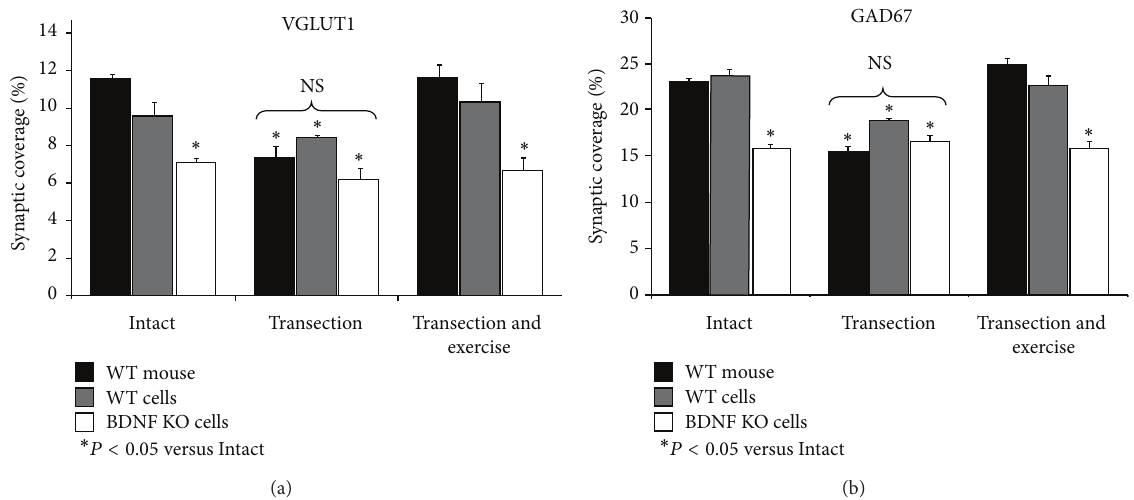
Figure 3: The mean (+SEM) percent of motoneuron somata and proximal dendrites that are contacted by structures immunoreactive for VGLUT1 (a) and GAD67 (b) in WT mice and for WT and KO cells in tamoxifen-treated SLICK::BDNF f / f mice are shown. Separate groups of three bars are shown in each panel for data from intact mice (left), unexercised mice two weeks after sciatic nerve transection (center), and two weeks after nerve transection and five days per week exercise (right) ( 𝑛 = 5 , 4, and 3 mice, resp.). The left group of results shows that synaptic coverage is significantly reduced in BDNF KO cells compared to WT mouse and WT cells in intact mice. Following nerve transection, synaptic coverage is significantly decreased in all cells, but coverage in BDNF KO cells is not changed from those seen in the intact animal. Exercise following transection restores synaptic coverage in all cells except the BDNF KO